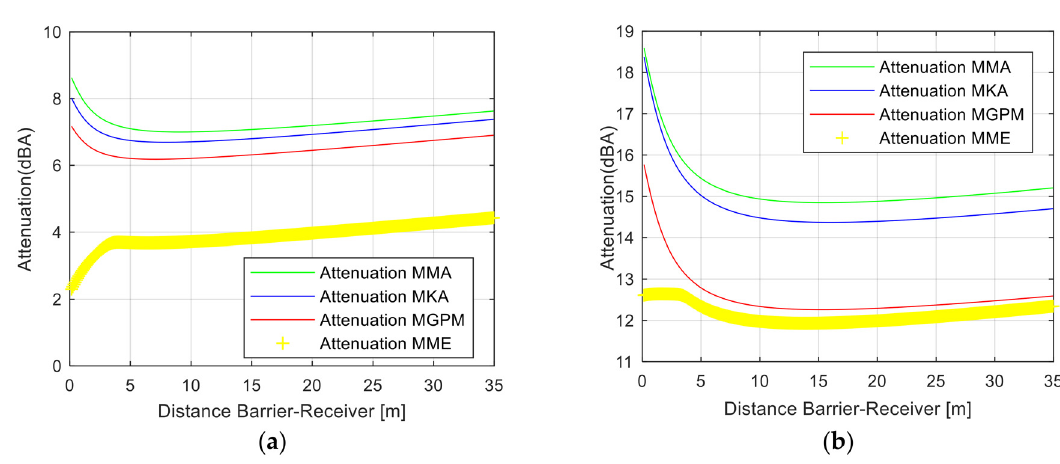
Figure 6. Sound attenuation as a function of the distance barrier-receiver and for a pure tone at 1000 Hz. ( a ) Relative humidity: 20%; σ e = 10 MPa · s · m − 2 . ( b ) Relative humidity: 20%; σ e = 104 kPa · s · m − 2 .